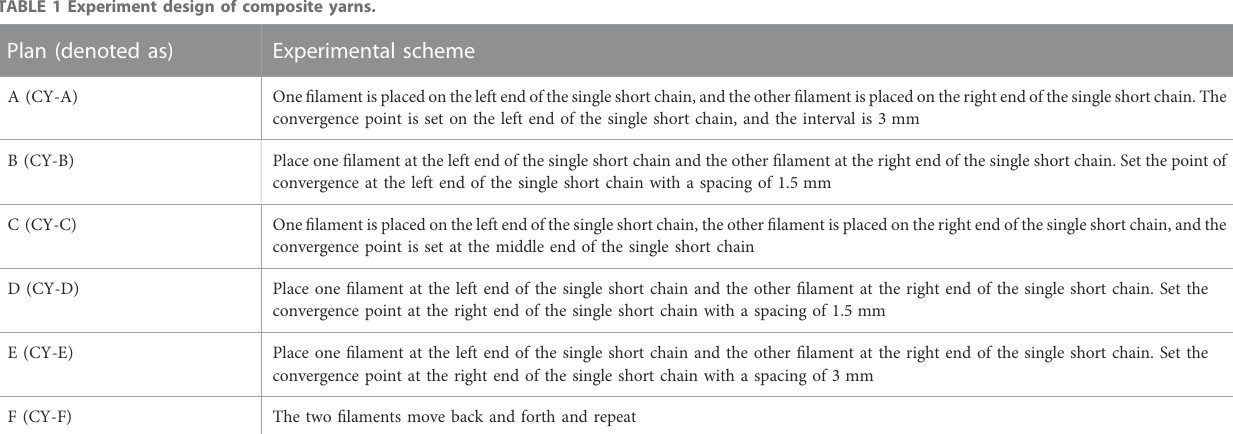
TABLE 1 Experiment design of composite